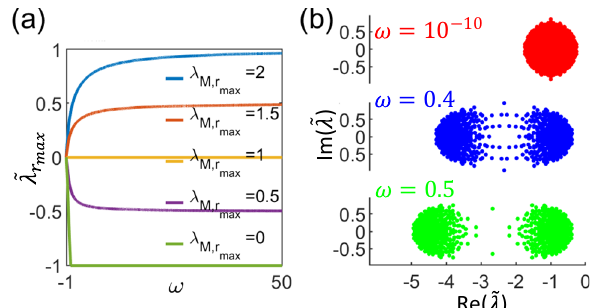
Fig. 6 Effect of degradation rates on stability. a The system is stable if and only if the maximal real part of the eigenvalues of the interaction matrix λ (cid:2) 1, regardless of the value of ω which increases with mRNA M ; r max degradation rates (Eq. (24)). The scaled eigenvalues ~ λ ! λ M (cid:3) 1 in the limit of fast mRNA degradation rate ω → ∞ (Eq. (23)). b Eigenvalue spectrum for different degradation rates τ . When mRNA and protein degradation rates are comparable, all eigenvalues fall within a circular region (red). On the other hand, when τ m ≪ τ p , the eigenvalue spectrum approximately resembles two circular regions, one corresponding to the dynamics of mRNAs and one for that of proteins. In this limit, increasing mRNA degradation rate only shifts the eigenvalues for the mRNA sector to more negative values, leaving the maximal real part of the eigenvalues approximately unchanged, ω = 0.5 (green) vs ω = 0.4